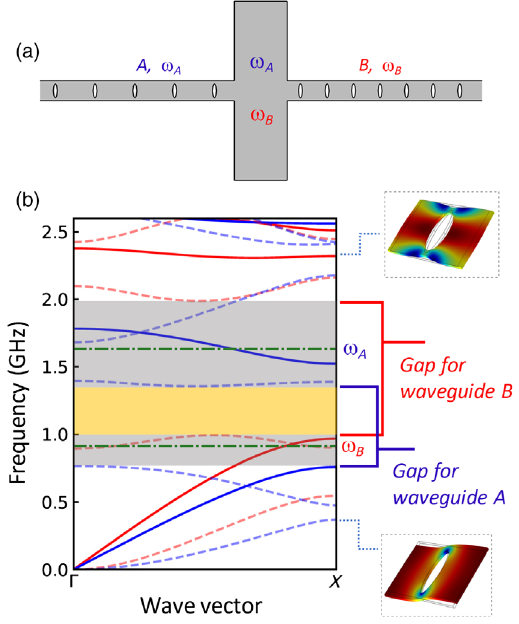
FIG. 3. (a) A mechanical resonator couples to two phononic crystal waveguides with a width of 3 μ m and a period of 6 μ m (waveguide A ) and 4 μ m (waveguide B ). For the elliptical holes in the waveguides, the minor (major) axes are 0 . 6 ð 2 . 2 Þ μ m. (b) Phononic band structures of the two waveguides. Each features a band gap. Blue (red) lines: Waveguide A ( B ). The gray (yellow) shaded areas show the nonoverlapping (overlap- ping) regions of the two band gaps. Solid (dashed) lines are for modes with displacement patterns that are symmetric (antisym- metric) about the plane that bisects and is normal to both the waveguide and the resonators. Dot-dashed lines indicate the frequencies of the two resonator modes ω and ω , used to A B couple to the respective waveguide